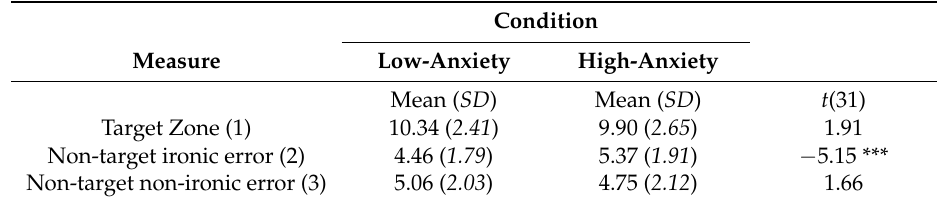
Table 2. Mean number of serves (SD) in the target, ironic and non-target non-ironic error zones, under the low-anxiety and high-anxiety